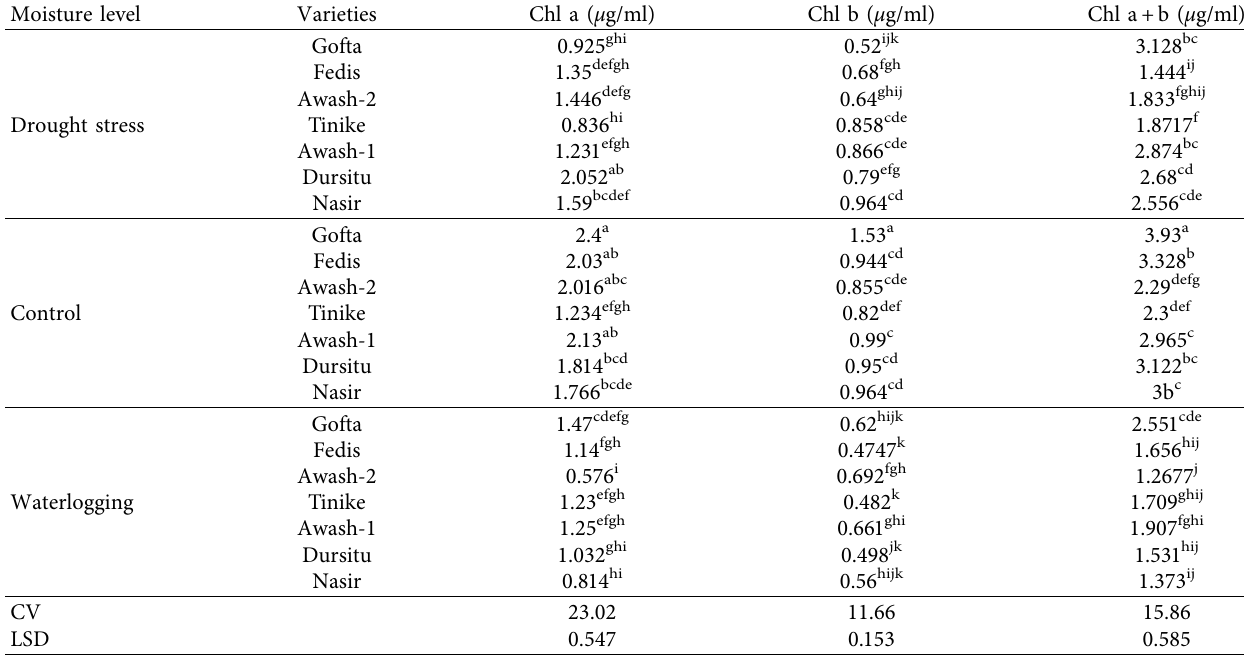
Table 6: Interaction efects of common bean varieties and soil irrigation interval on chlorophyll a, b, and a +b under Lath House from June to September, 2020. Moisture